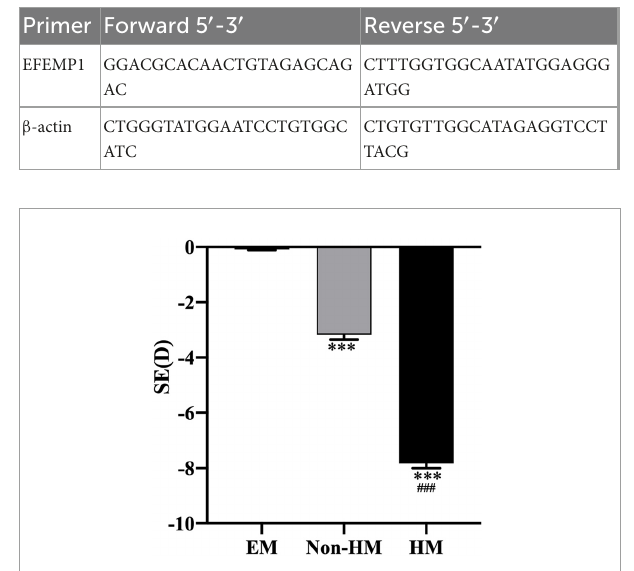
FIGURE2 Spherical equivalent in the right eyes of the three groups. ∗∗∗ p < 0.001, compared with EM group; ### p < 0.001,